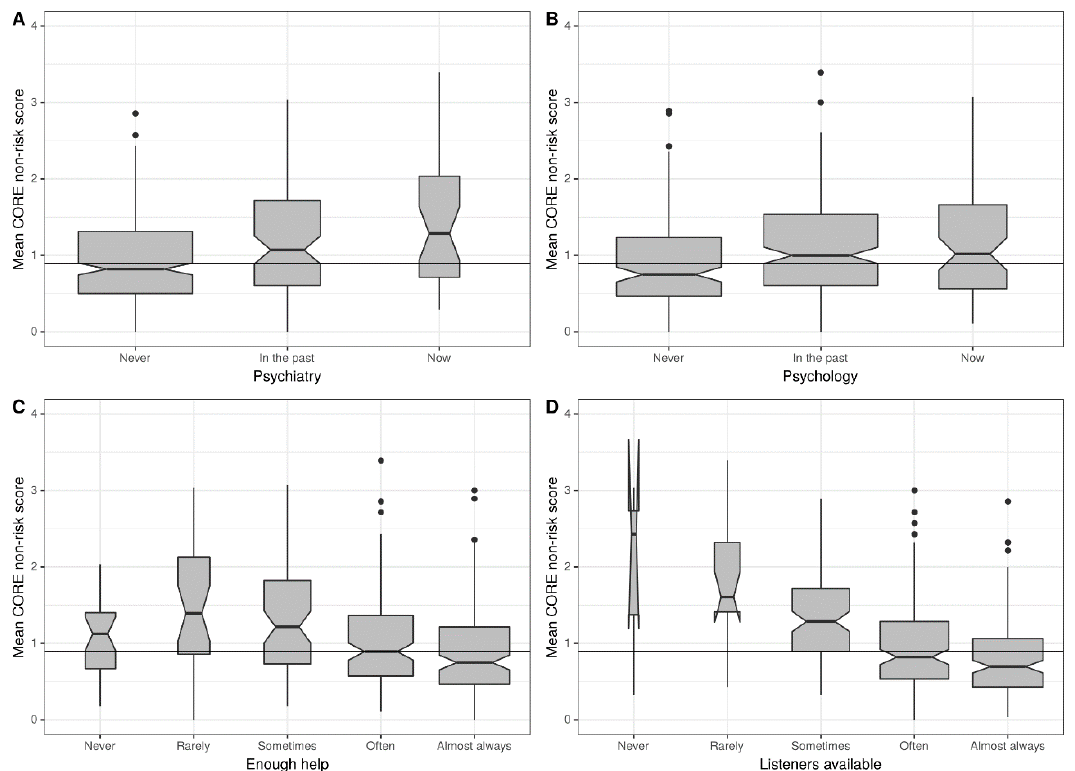
Figure 3. Relationship between general support and professional support with CORE-OM NR score. The four separate figures each show the relationship between mean CORE-OM non-risk score and respectively: contact with a psychiatrist ( A ), contact with professional psychological support ( B ), perception by the participant of availability of lay help ( C ) and perception of having listeners available ( D ). Box areas are proportion to cell size and notches show approximate 95% CI of the median. Horizontal reference lines are overall median scores.